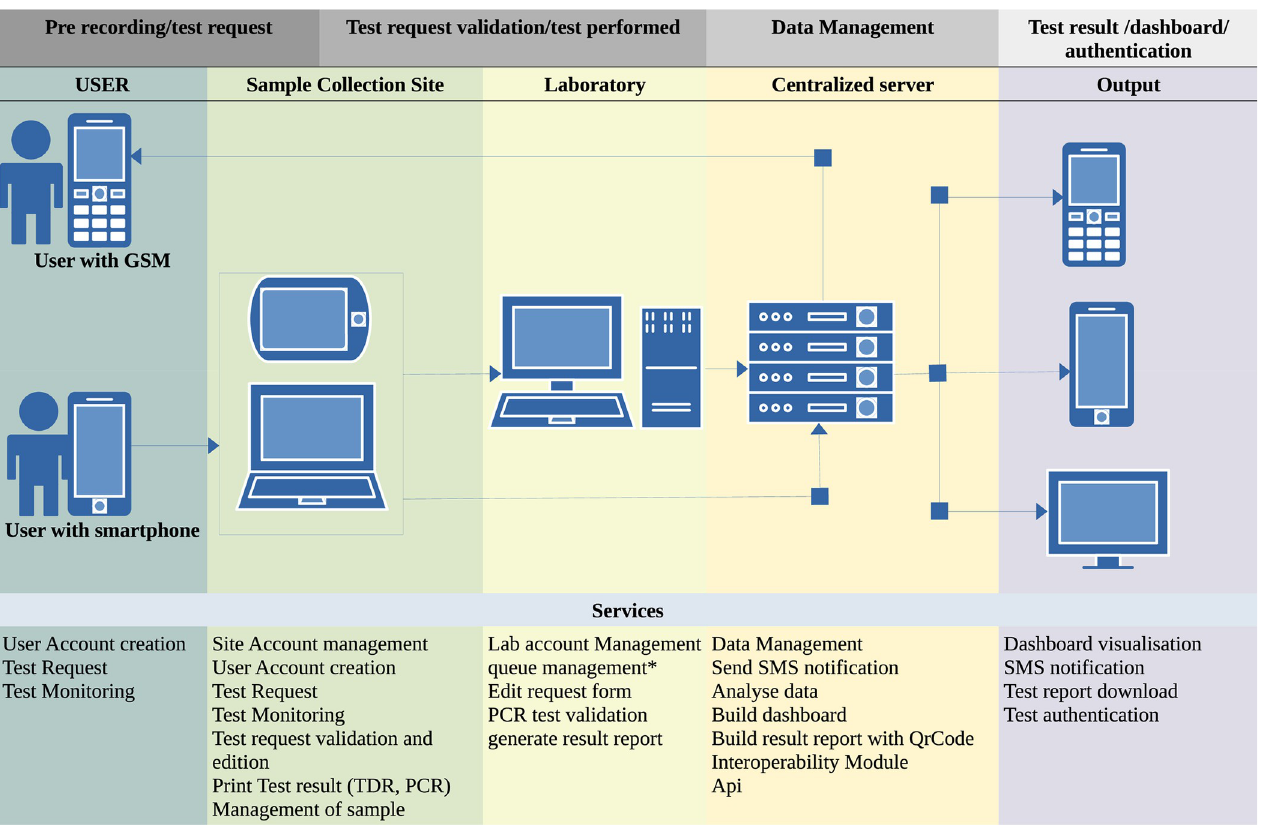
Fig 1. PlaCARD data flow for COVID 19 Diagnostic data management and